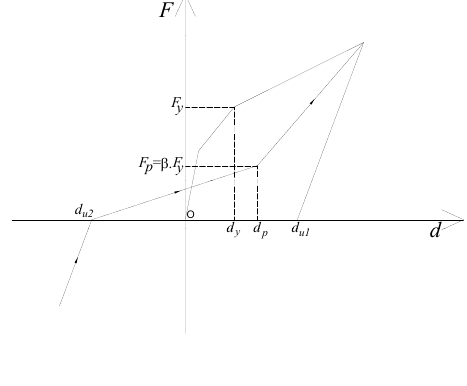
Figure 6. “Pinching” effect.